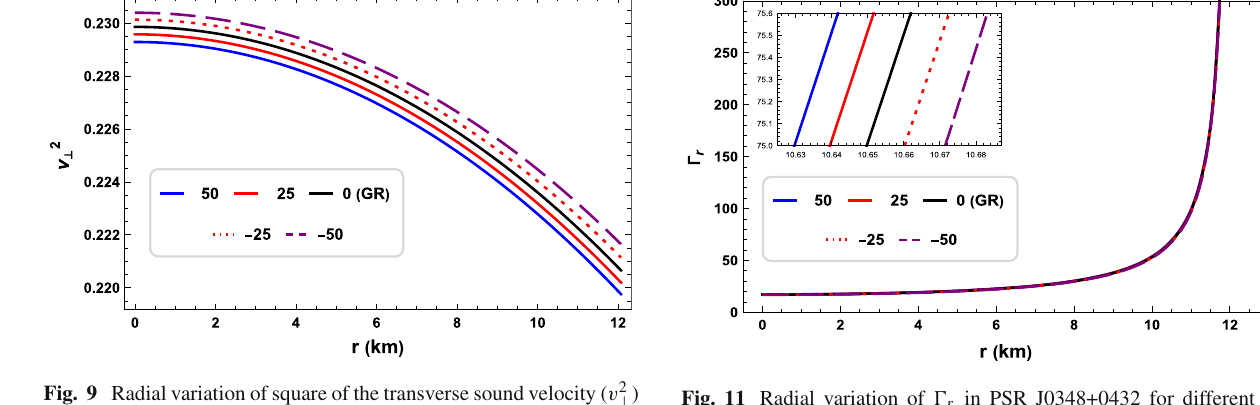
Fig. 11 Radial variation of (cid:12) r in PSR J0348+0432 for different α values in 5D